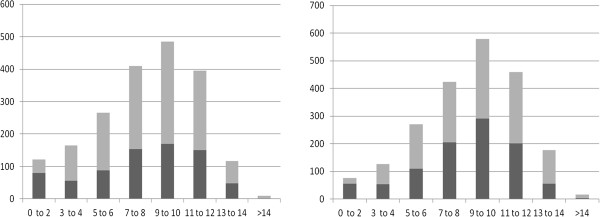
Age distribution of benign and malignant tumours as diagnosed by means of histology (Left) or cytology (Right). Horizontal axis: Age of the dogs (years); vertical axis: Number of cases diagnosed. Dark grey: Benign tumours. Light grey: Malignant tumours.